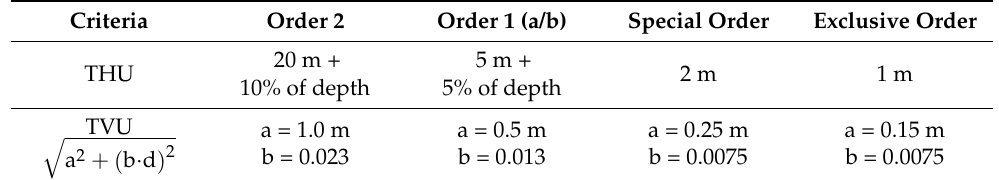
Table 15. THU e TVU bathymetry IHO standards for safety of navigation hydrographic surveys [17]. Criteria Order